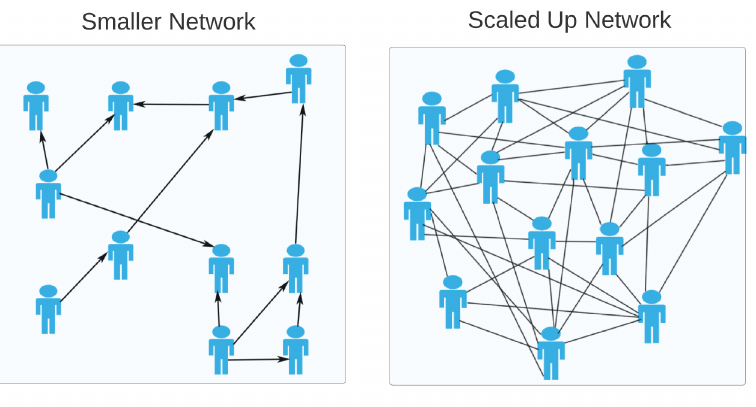
Figure 4. Scaling in a distributed network is simpler because new nodes contribute their own